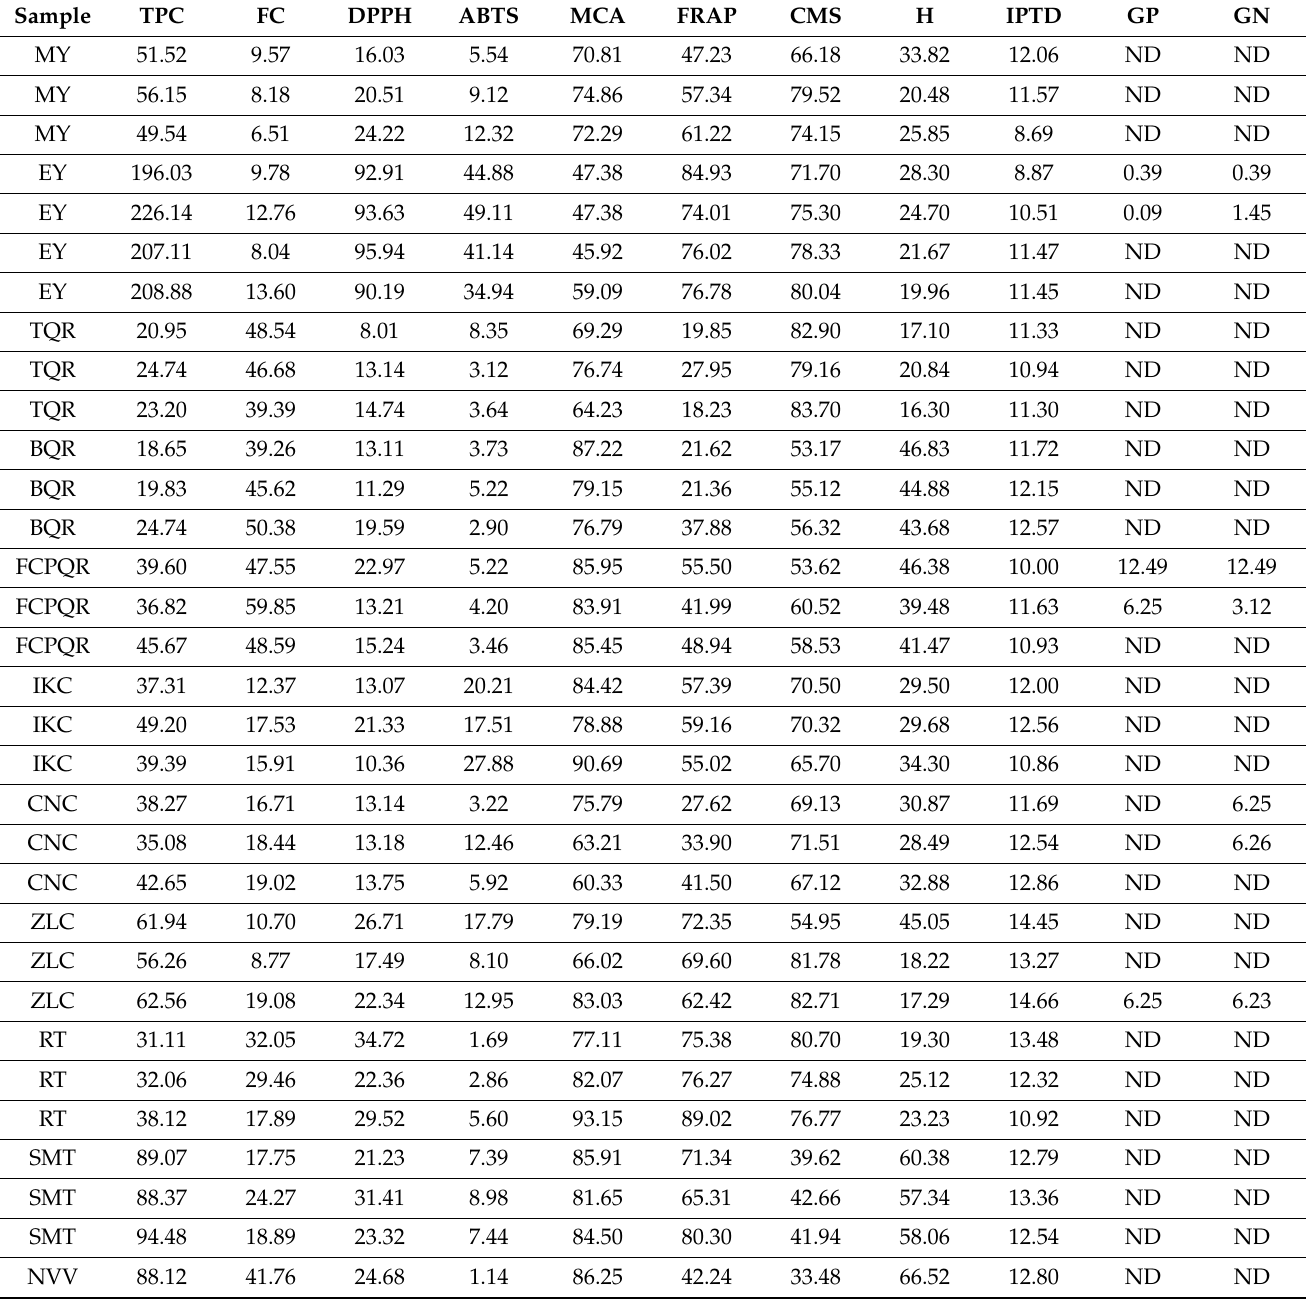
Table 2. Total phenolic content, flavonoid content, and in vitro assays of antioxidant, anti-inflammatory, and antibacterial activities of propolis extracts from Melipona beecheii hives by